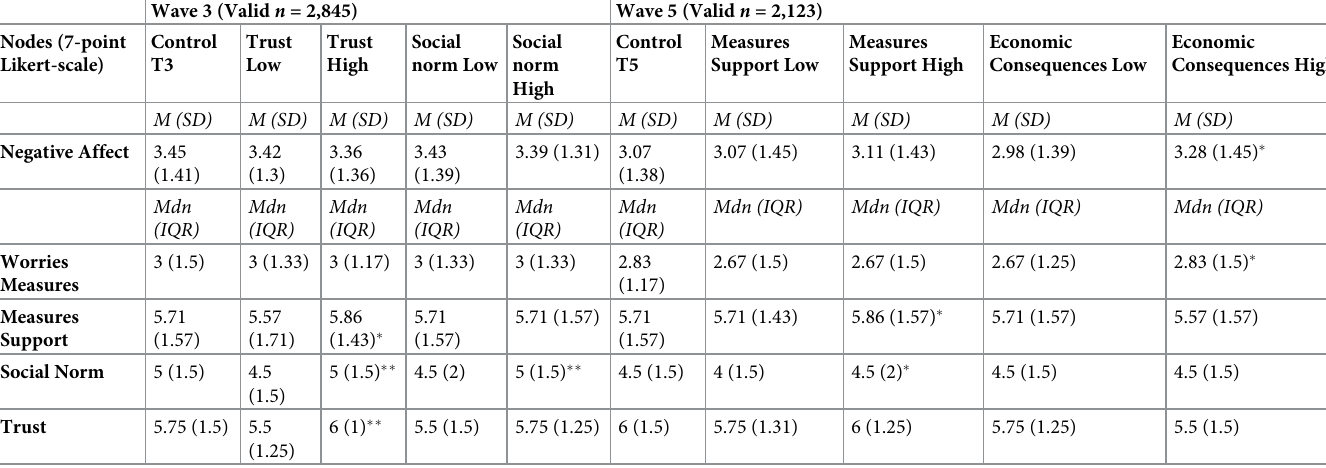
Table 3. Statistics of nodes that differed significantly ( p < .01) between intervention conditions in wave 3 and 5. Including one way ANOVA/Kruskal–Wallis results for comparing conditions (including control condition).